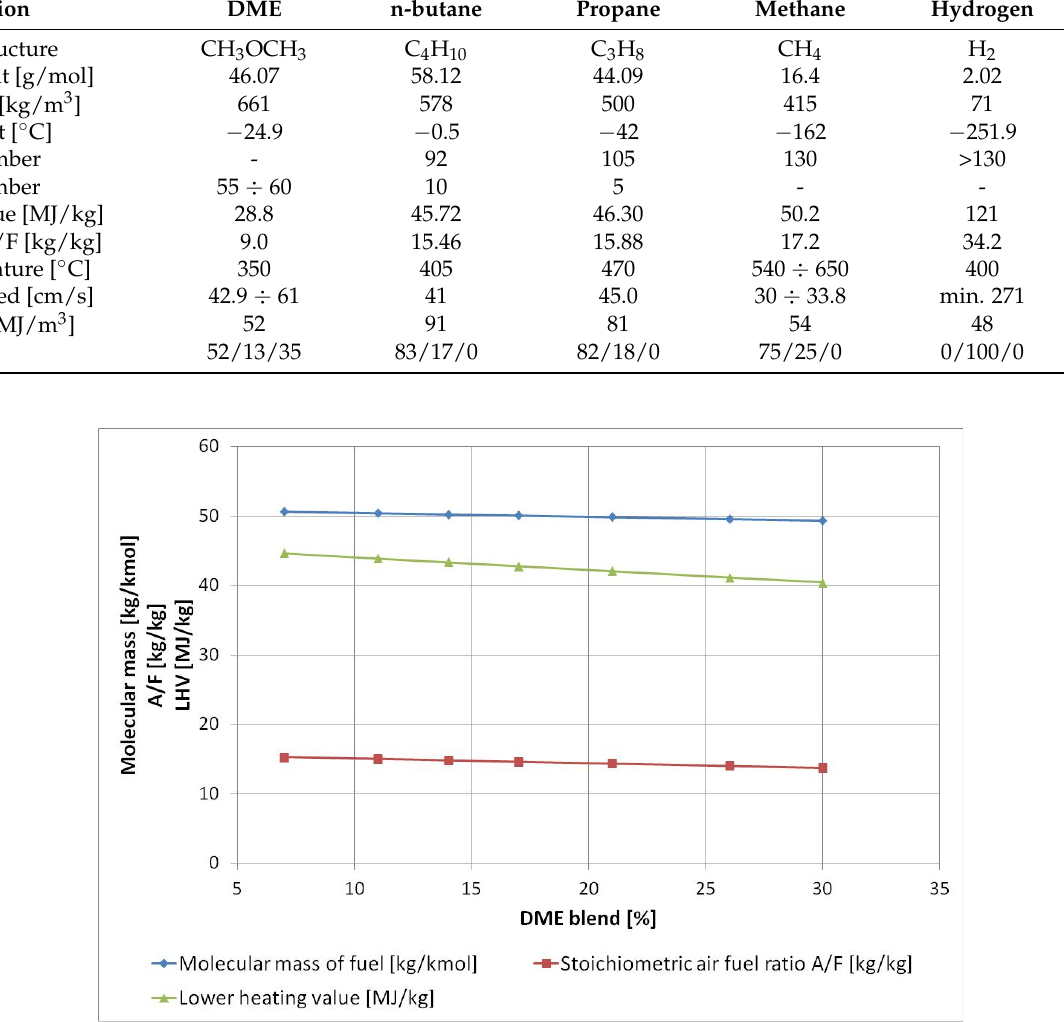
Table 2. Physical and chemical properties of DME and similar, other fuels [20,21].